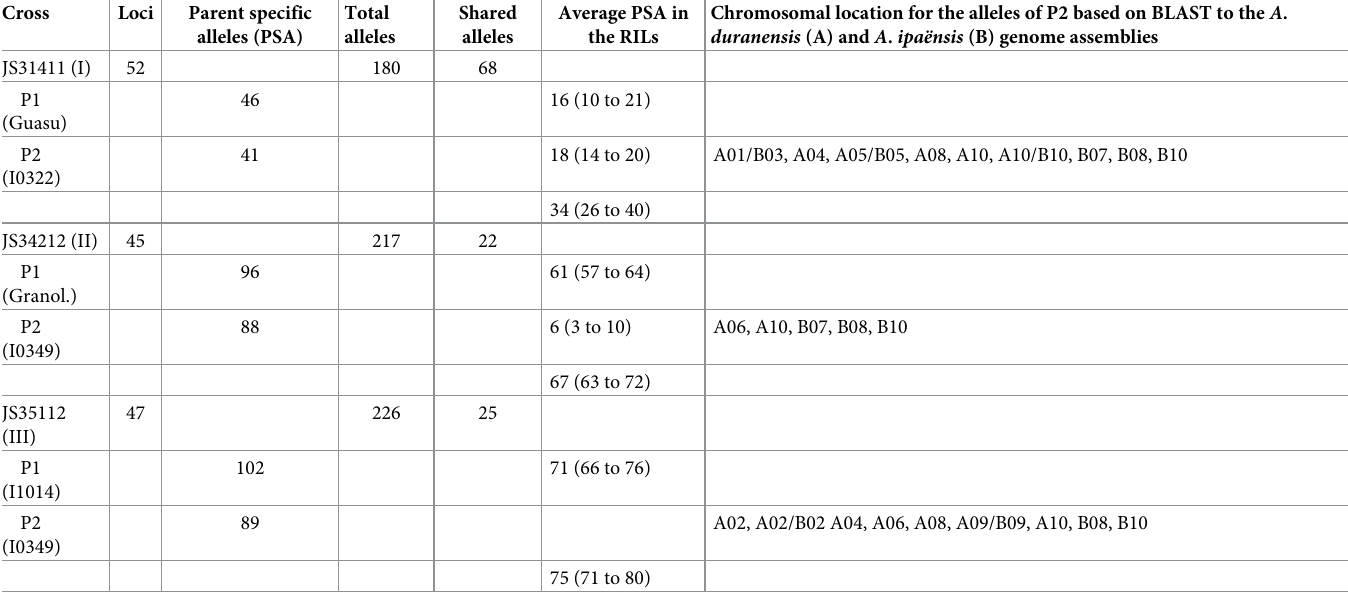
Table 4. Summary of molecular marker analysis for each of the crosses. P1: susceptible parent; P2: resistant parent. Parent specific alleles (PSA) are alleles present in only one of the parents. Shared alleles: are alleles present in both parents and in all their progeny. PSA in progeny: is the average number of alleles present in each individual progeny that originated either from parent P1 or P2